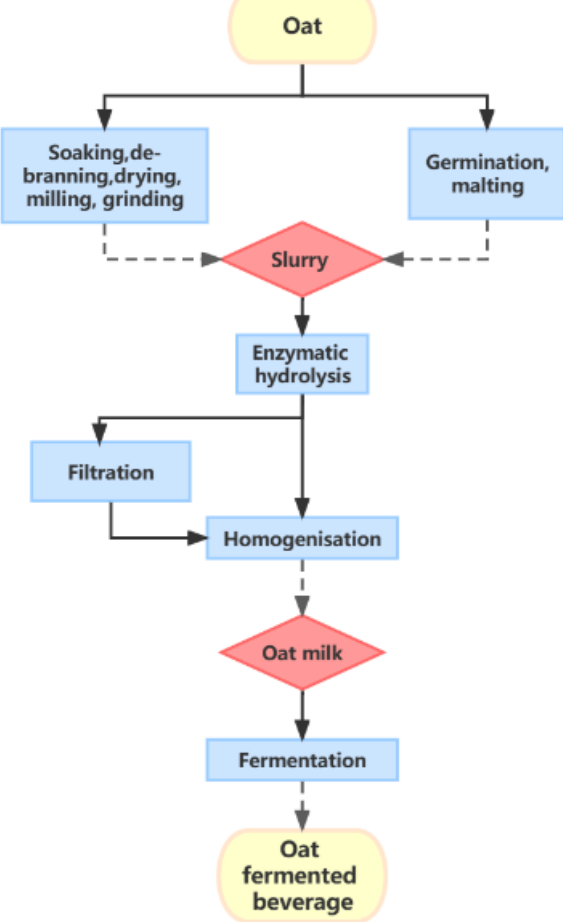
Figure 2. Preparation process of fermented oat beverages.